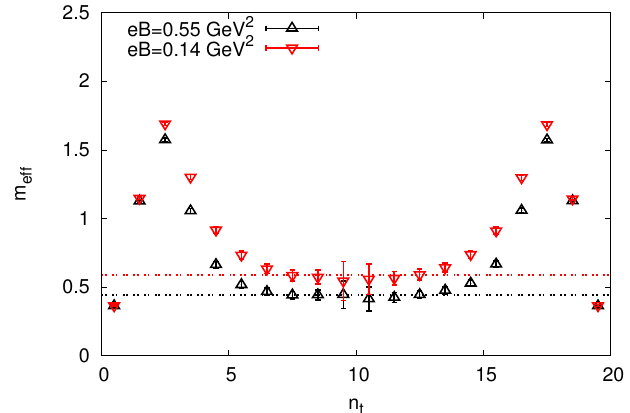
Figure 2. The e(cid:11)ective mass of the (cid:26) + ( (cid:26) (cid:0) ) meson with the s z = +1 ( s z = (cid:0) 1) spin projection for m (cid:25) ( B = 0) = 535(4) MeV. The lines correspond to the (cid:12)ts of the m e(cid:11) by the constant function at n 0 = 6.